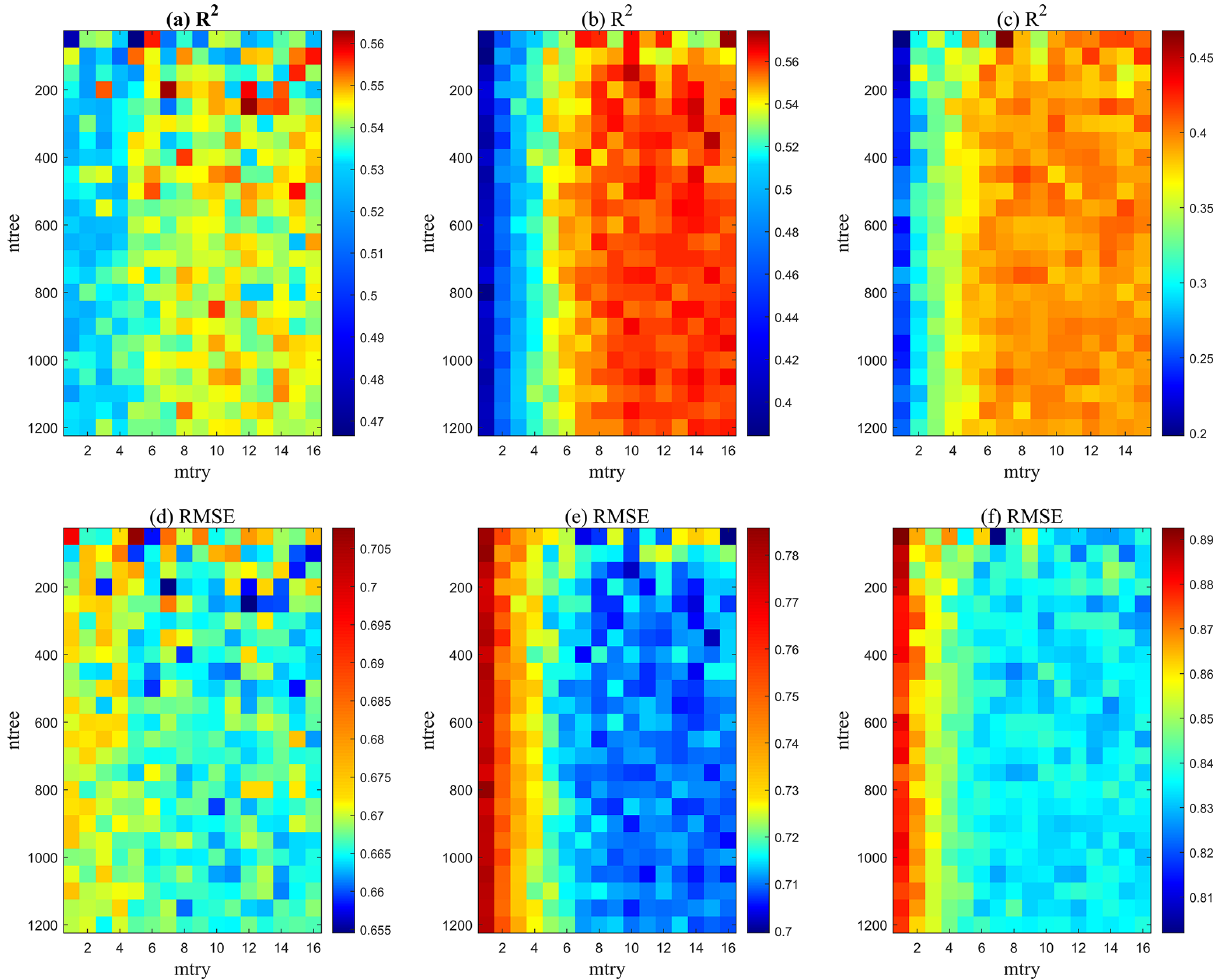
Figure 4. The (a–c) R 2 (coefficient of determination) and (d–f) RMSE (root-mean-square error) changes with the parameters Ntree and Mtry of the model using the dataset on (a, d) 11 August 2013, (b, e) 2 September 2015, and (c, f) 21 July 2017. Table 2. R 2 and RMSE of the RF model with different buffer radii (500, 1000, 2000, 5000m). Date format: